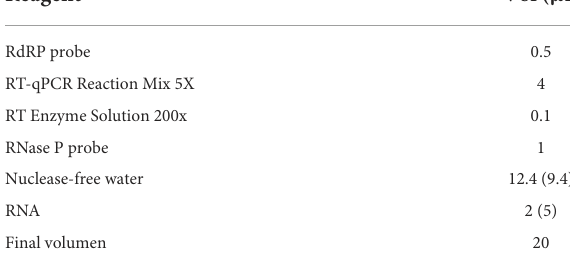
TABLE 2 BGI mix RT-qPCR mix.